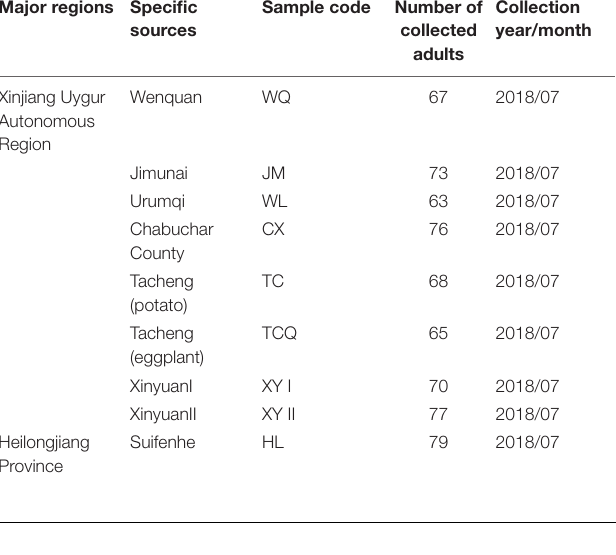
TABLE 1 | Collection and sequencing of samples information of L. decemlineata.